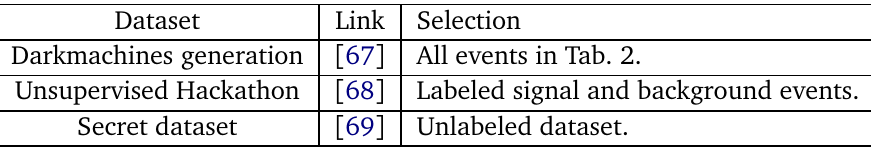
Table 4: The different datasets and their Zenodo